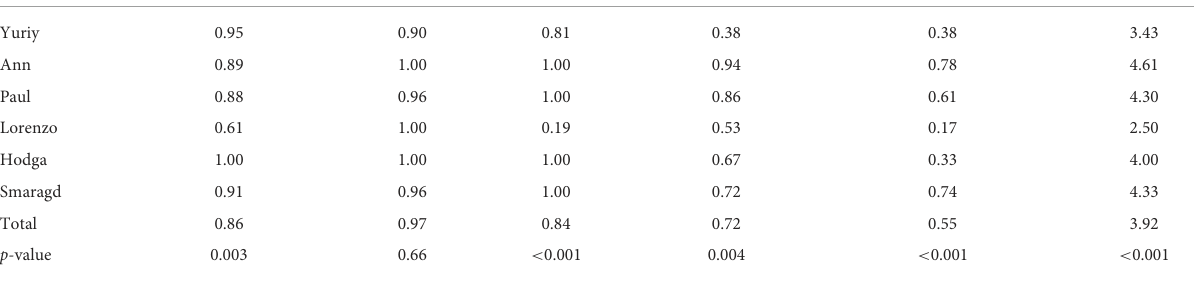
TABLE 6 Global perception of each character (normalized global score index over all responses for each character). Character Most anthropomorphic Most alive Most attractive Most intelligent Inspires most confidence Global